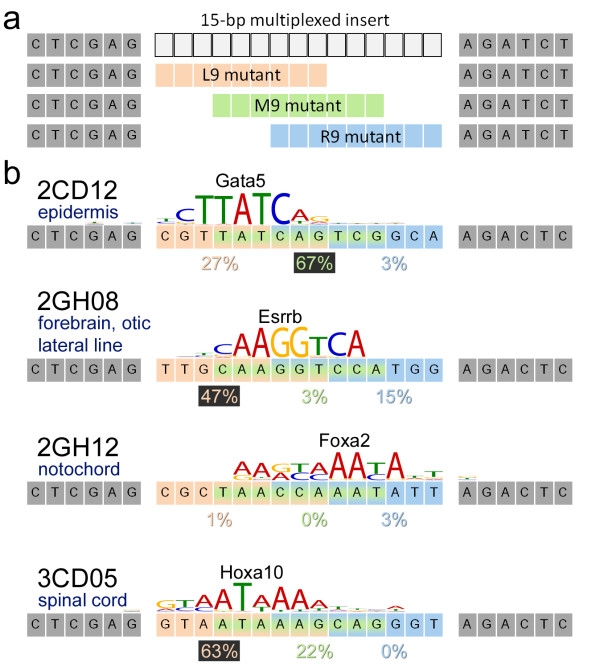
Functional dissection of multiplexed sequences reveals key motifs. (a) We tested three deletion mutants for each of the four tissue-specific multiplexed sequences, using the first (L9, peach), middle (M9, green) and last (R9, blue) 9 bp of each sequence cloned between the same flanking sequences. (b) With one exception (2GH12/notochord), a 9-bp sequence was sufficient to drive the expression pattern of the original multiplexed construct. Percentages of fish expressing in the appropriate tissue at 24 hpf are shown, with the value for the functional 9-mer highlighted in black. The top-matching position weight-matrix identified by Tomtom [30] is listed for each construct.